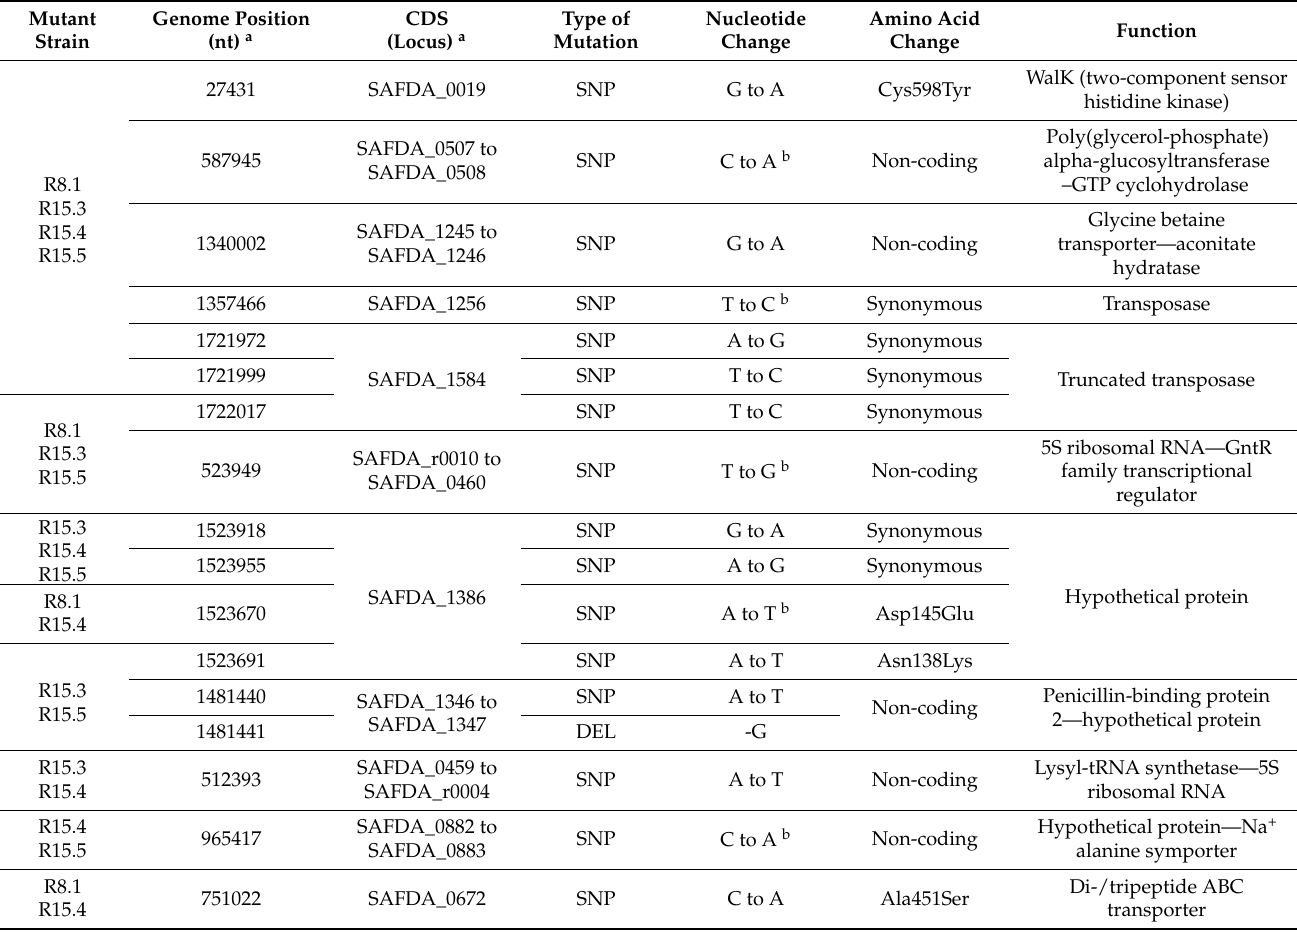
Table 2. Summary of mutations observed in at least two mutants resistant to